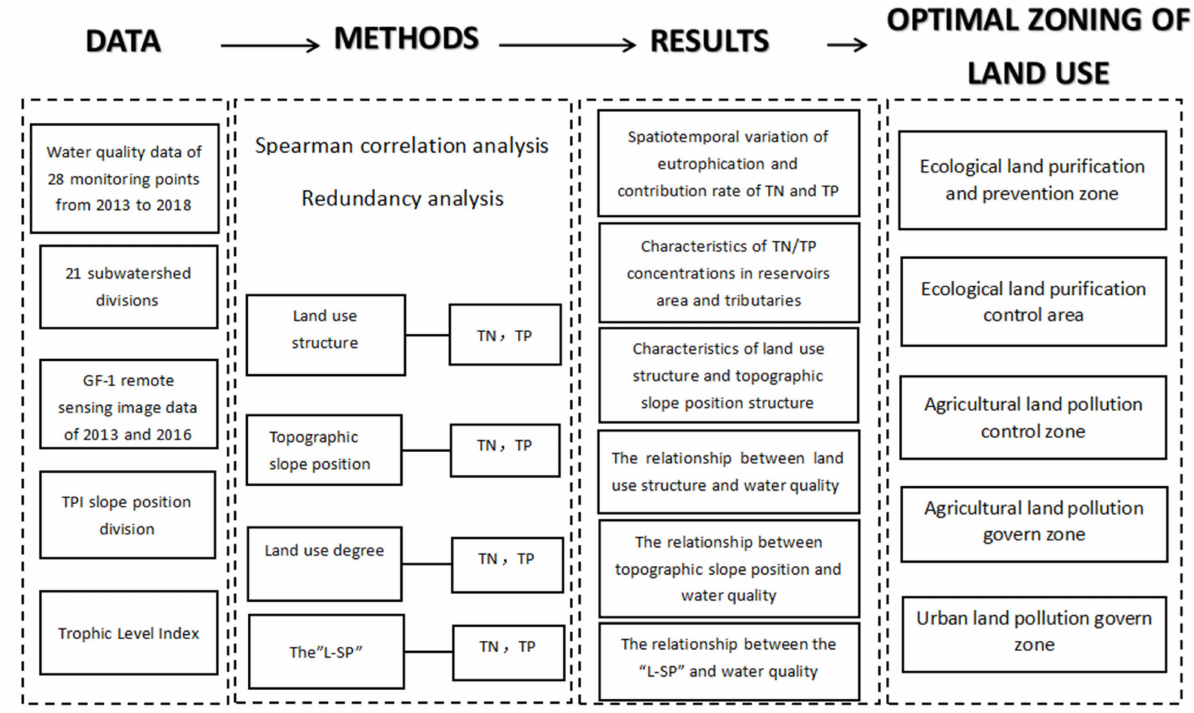
Figure 2. Technical